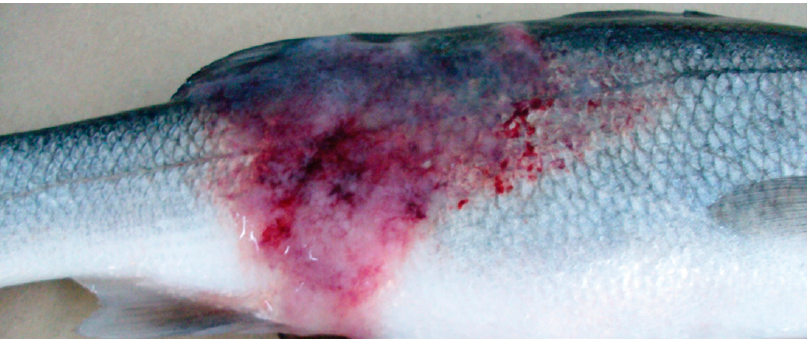
Figure 1. Ulcerative dermal lesions attributed to Mycobacterium spp. in striped bass (From Avsever et al. 2016, released under Creative commons [51]).